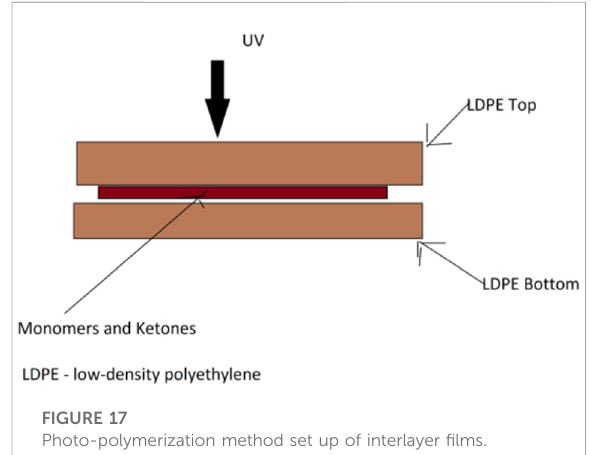
FIGURE 17 Photo-polymerization method set up of interlayer fi